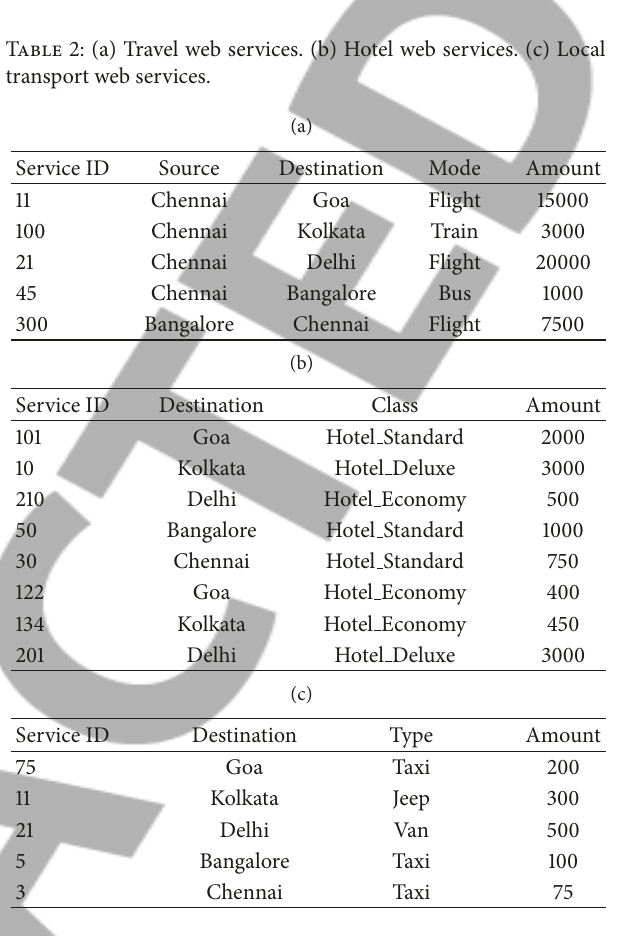
Table 2: (a) Travel web services. (b) Hotel web services. (c) Local transport web